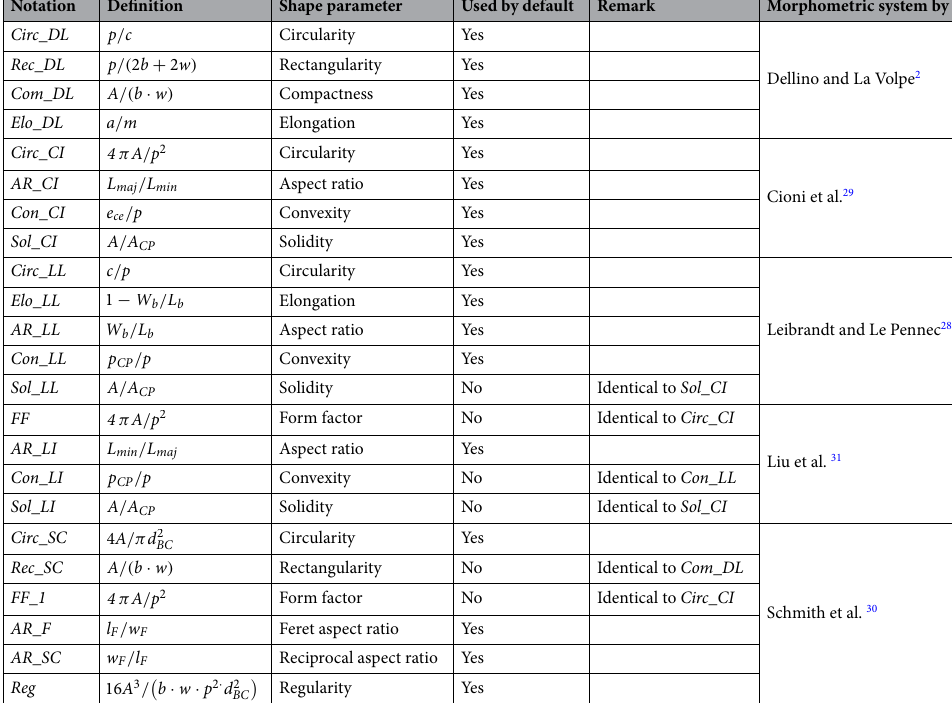
Table 1. Notation of shape parameters and respective morphometric systems analysed by DendroScan. Shape parameters which are mathematically equivalent and therefore would provide redundant information, are omitted by default for DendroScan analyses, but could nevertheless be activated by the user. Definitions for each shape parameter are provided in the second column, with p particle perimeter, A projected particle area, w short side of the minimum area bounding rectangle, b long side of the minimum area bounding rectangle, c perimeter of the circle with area A , a maximum intercept, m mean intercept perpendicular to a , L b maximum length of all possible lines from one point of the perimeter to another point on the perimeter projected on the major axis of the particle, W b maximum of all possible lines from one point of the perimeter to another point on the perimeter, projected on the minor particle axis, p cp perimeter of smallest convex polygon around particle, A cp area of smallest convex polygon around particle, e ce perimeter the smallest area ellipse that encloses, but does not intersect the particle, L maj major axis of best fit ellipse, L min minor axis of best fit ellipse, d BC diameter of circle that encloses, but not intersects particle, l F minimum Feret length, w F Feret length perpendicular to l F and d F maximum Feret distance. For further details see Table 1 in Dürig et al. 32